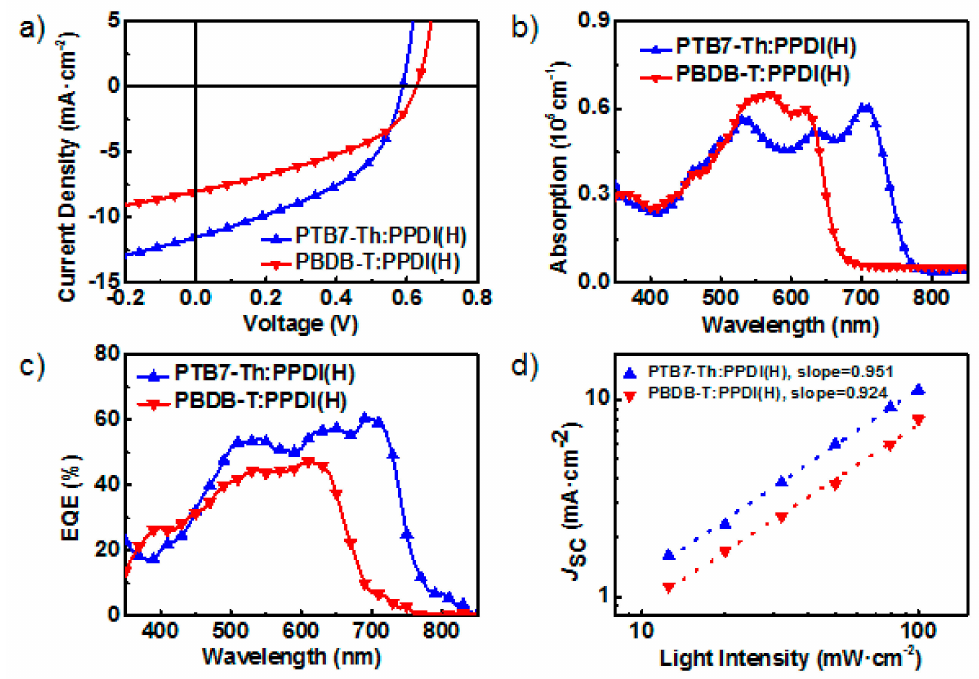
Figure 3. ( a ) The current density − voltage (J-V) curves of PPDI(H)-based All-PSCs; ( b ) absorption coe ffi cient of PTB7-Th:PPDI(H) and PBDB-T:PPDI(H) blend films; ( c ) EQE of PPDI(H)-based All-PSCs; ( d ) short current density ( J SC ) versus light intensity of the PTB7-Th-based devices and PBDB-T-based devices. Table 3. Photovoltaic properties of All-PSCs under the illumination of AM 1.5 G, 100 mW · cm 2. Blend